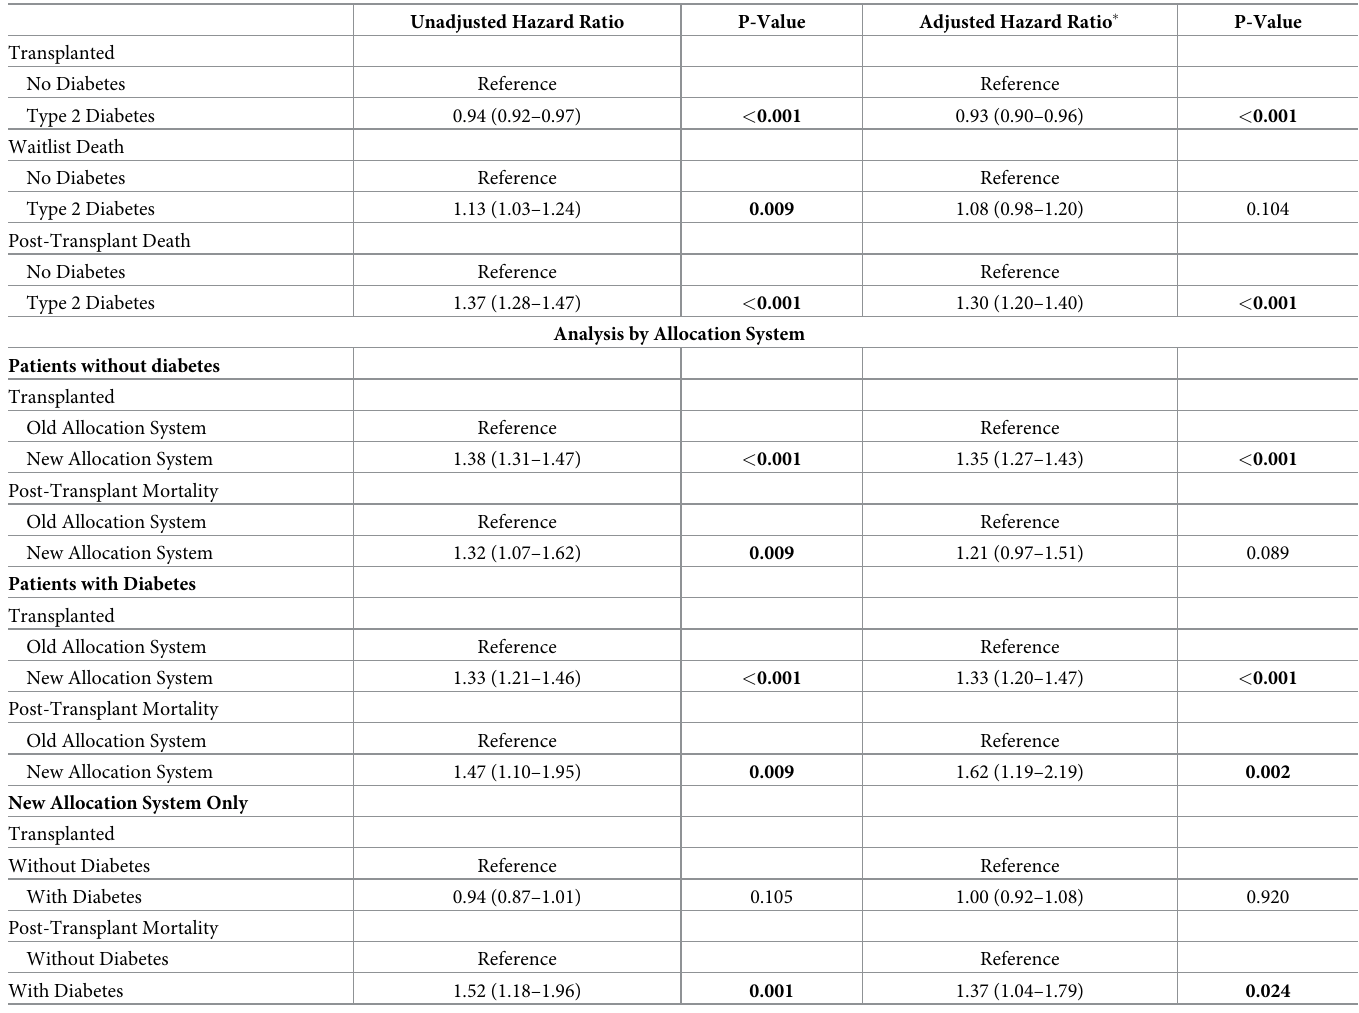
Table 3. Cox regression for outcomes.